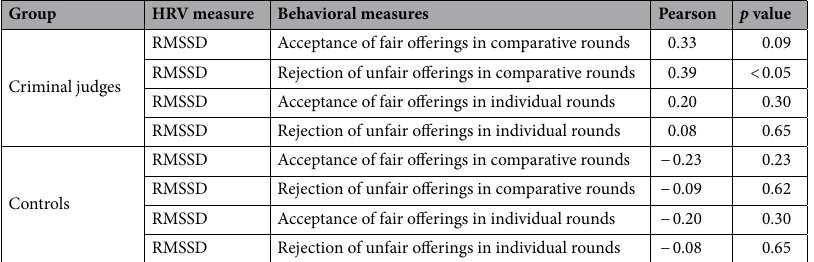
Table 3. Correlations between HRV and behavior in Ultimatum